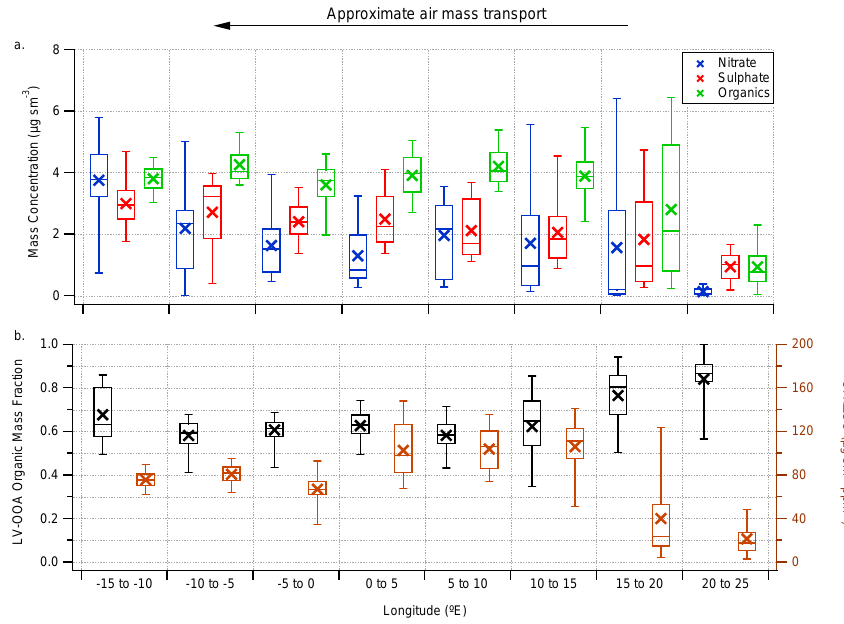
Fig. 6. Boxplot summary statistics of aerosol chemical composition as a function of longitude during LONGREX-2, where the air mass transport was approximately east-to-west. (a) Summarises the concentrations for nitrate, sulphate and organics. (b) Presents the LV-OOA organic mass fraction (left) and the OM: 1 CO ratio (right). Crosses represent the mean value, while horizontal lines represent the 25th, 50th and 75th percentiles. The whiskers represent the 5th and 95th percentiles. Values are for altitudes between